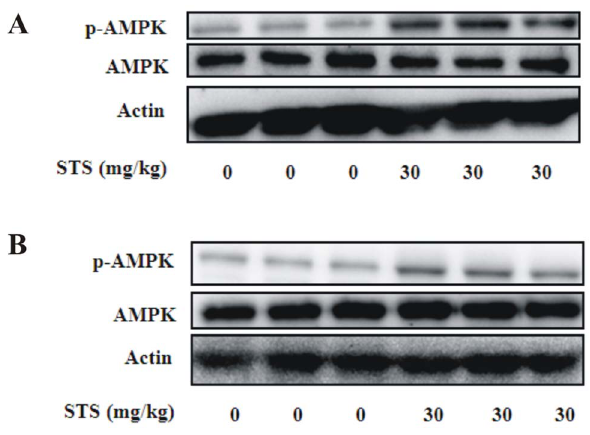
Figure 7. Effect of oral administration of STS on phosphory- lation of AMPK in aortic tissue. Samples were prepared from aortas of male (A) ob/ob or (B) db/db mice. STS (30 mg/kg) was administered orally for 10 days. n=6 for each